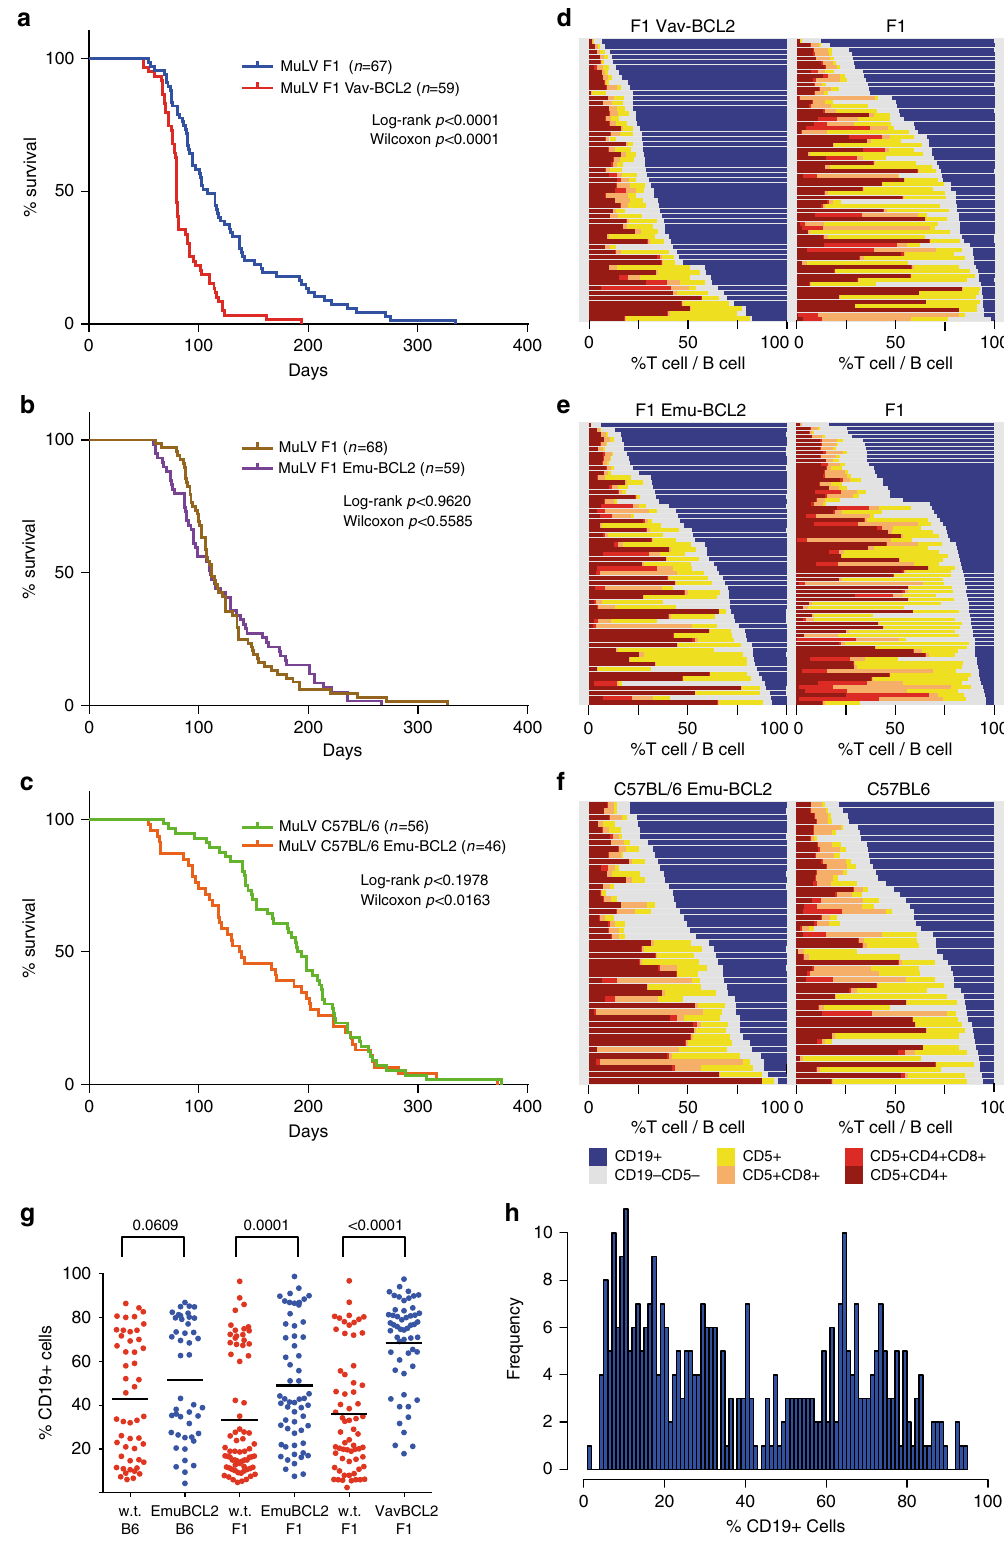
Fig. 2c the 50 insertions with the highest NC values within each sample are ordered by their relative abundance and plotted as bar graphs. Early-stage samples from the time course had a fl at pro fi le of subclonal mutations with the majority represented by a single read/DNA fragment, whereas later stage lymphoma samples